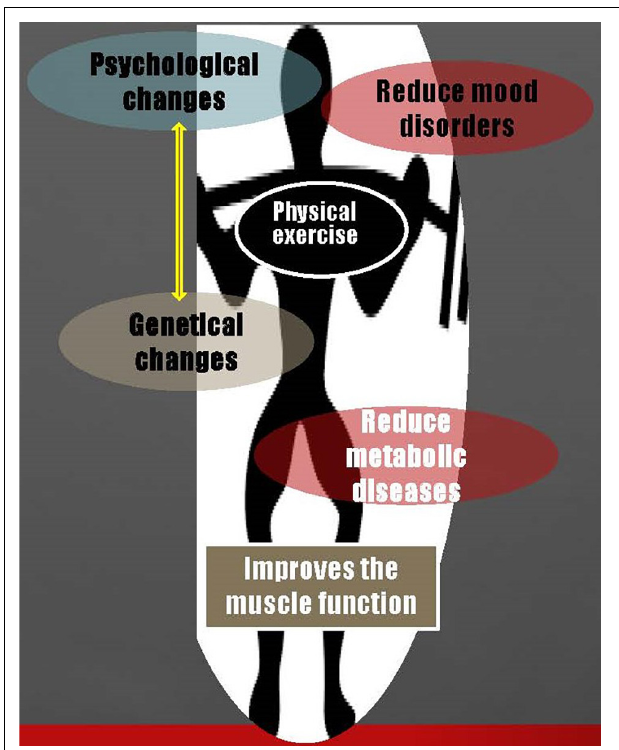
FIGURE 1 | Physical exercise influences physiological, psychological, and genetical changes, which results in producing various benefits, including preventing metabolic and mood